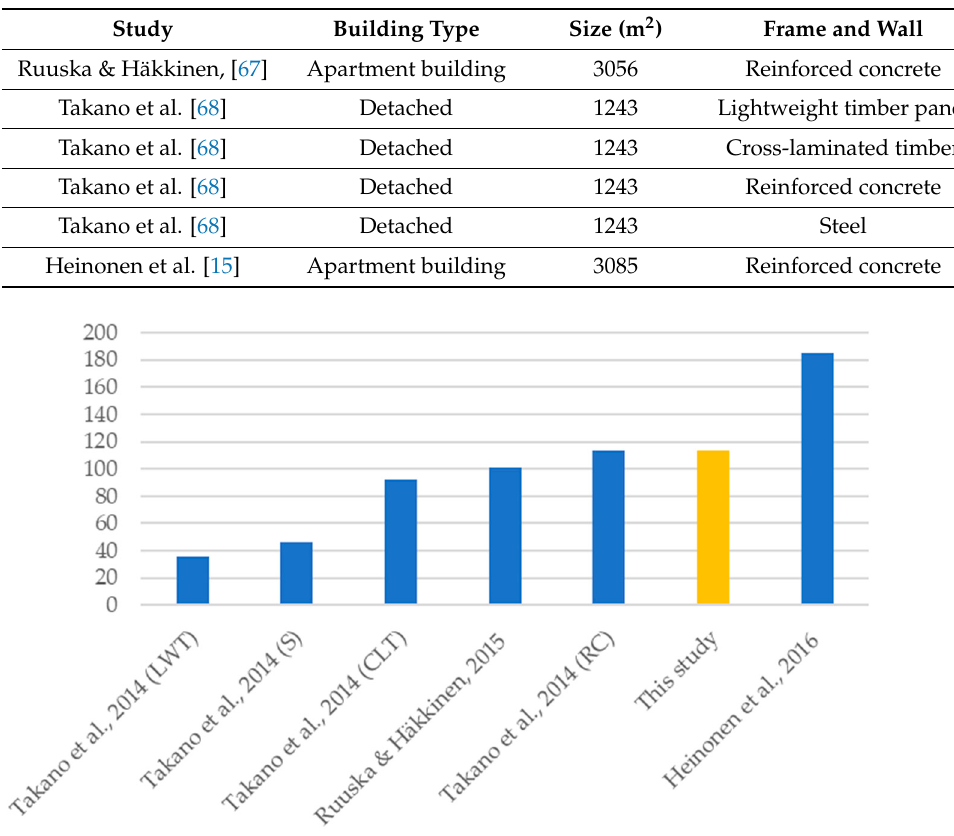
Figure 10. GWP reported for frame/wall materials from previous LCA studies reported as kg CO 2 eq/m 2 , compared to this